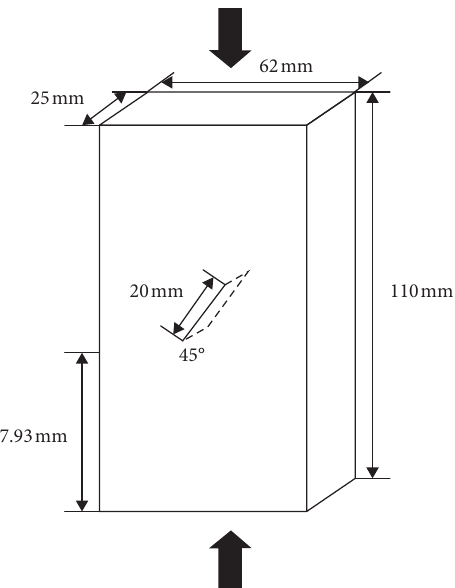
Figure 10: Schematic diagram of cracks subjected to uniaxial